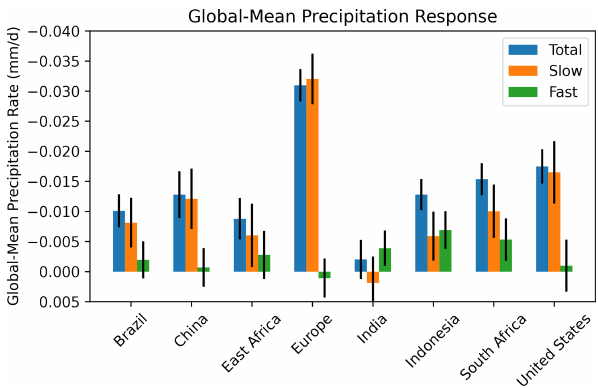
Figure A4. As in Fig. 3 but for the second simulation set conducted with adjusted initial conditions (see Sect. 2).